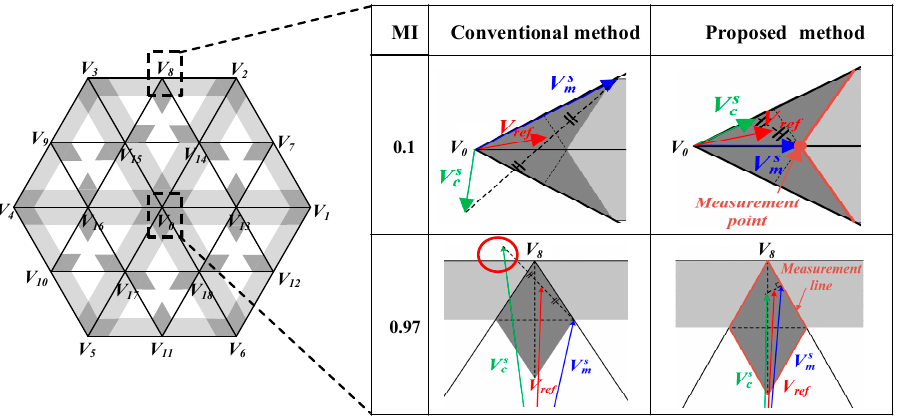
Figure 22. Comparison of conventional method and proposed method at MI = 0.1 and MI = 0.97.